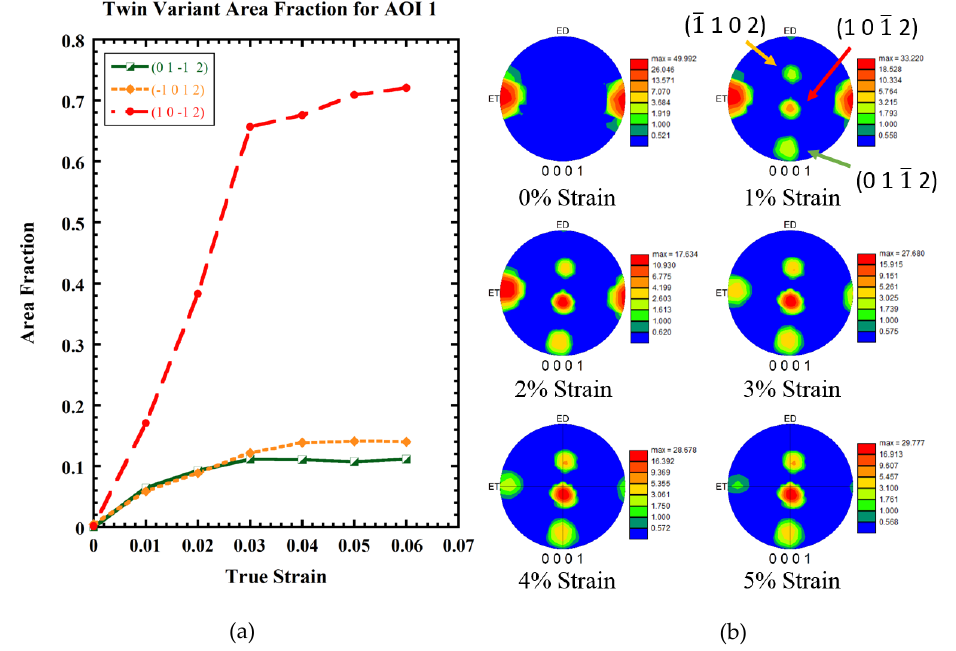
Figure 15. ( a ) Evolution of twin variant area fraction with strain for the three distinct pairs of the { 1012 } system in AOI 1. ( b ) ( 0001 ) pole figures showing the nucleation of three dominate twin variants forming at 1% strain then growing in intensity as the parent orientation